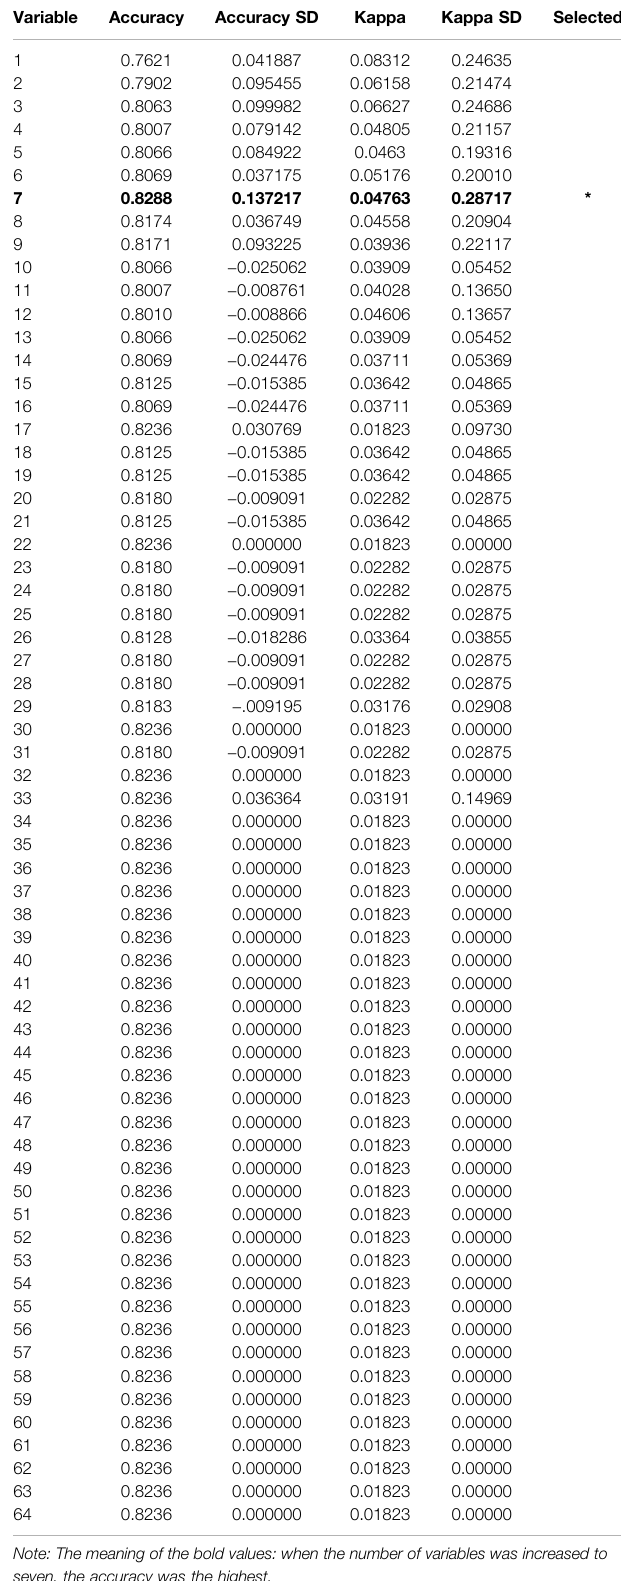
TABLE 2| Resultsoftherecursivefeatureselectionperformedonthetrainingdataset. Variable